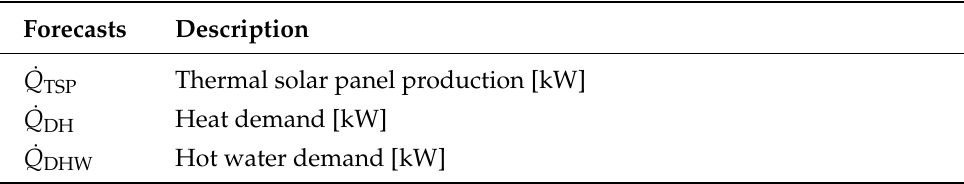
Table 3. Thermal